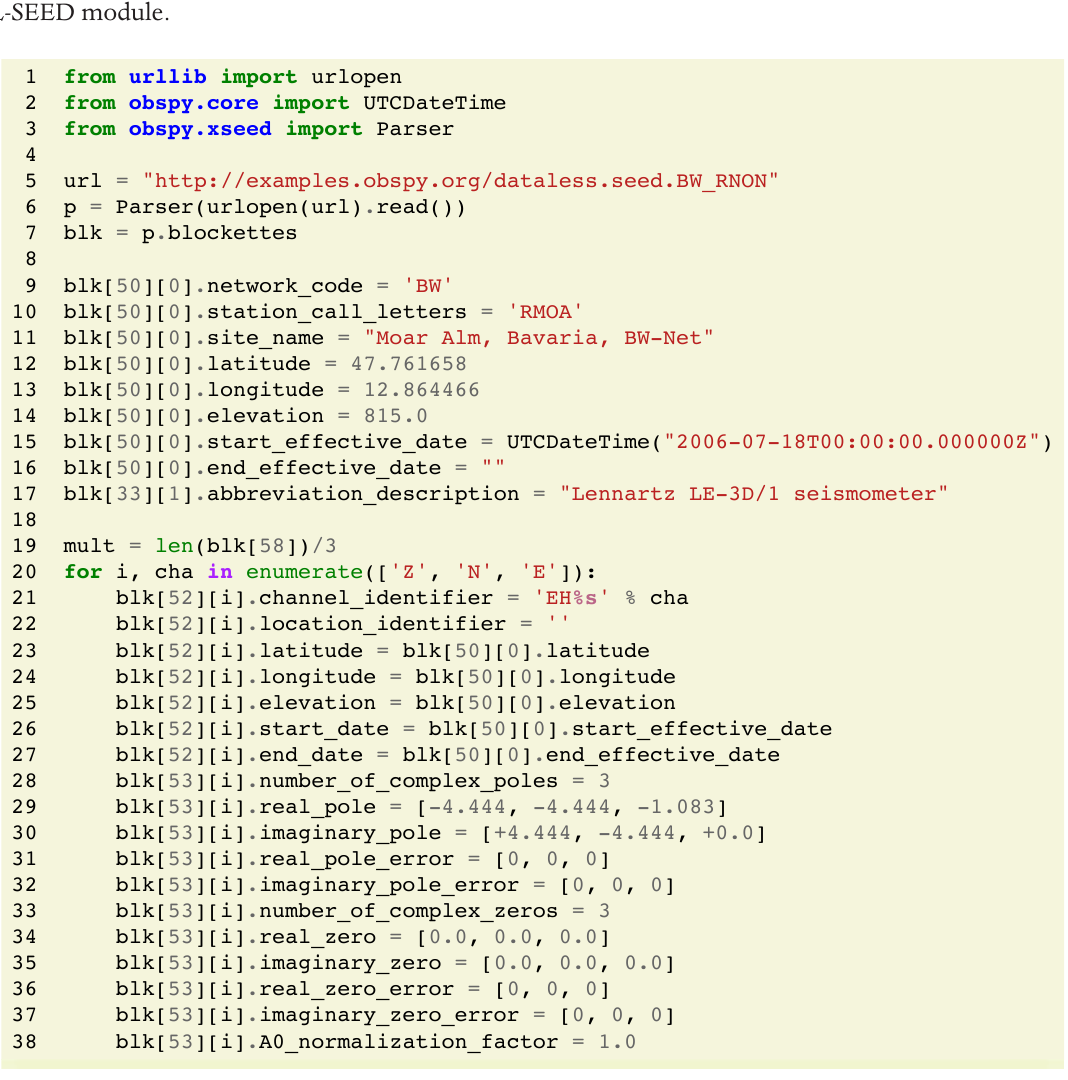
Figure 16 (continues on next page). Example code: Cloning a Dataless SEED file, filling in all of the important